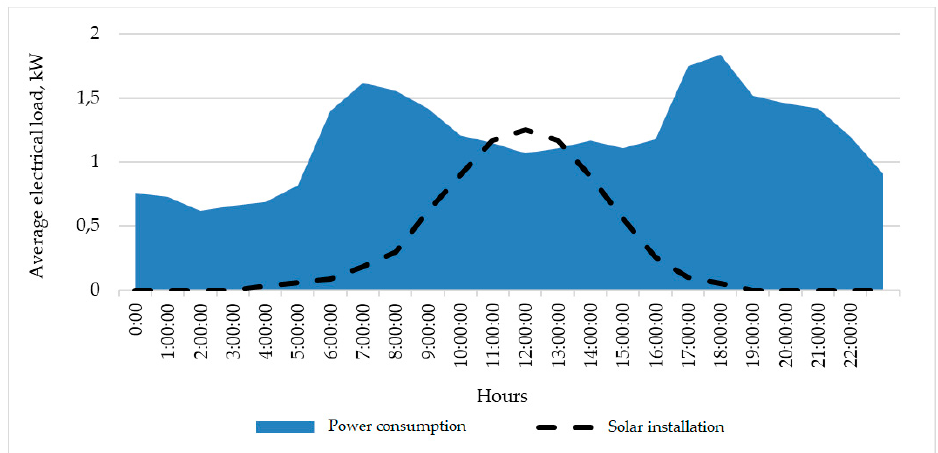
Figure 5. Household electrical load graph on a working day with a superimposed graph of electricity generated by solar installations.